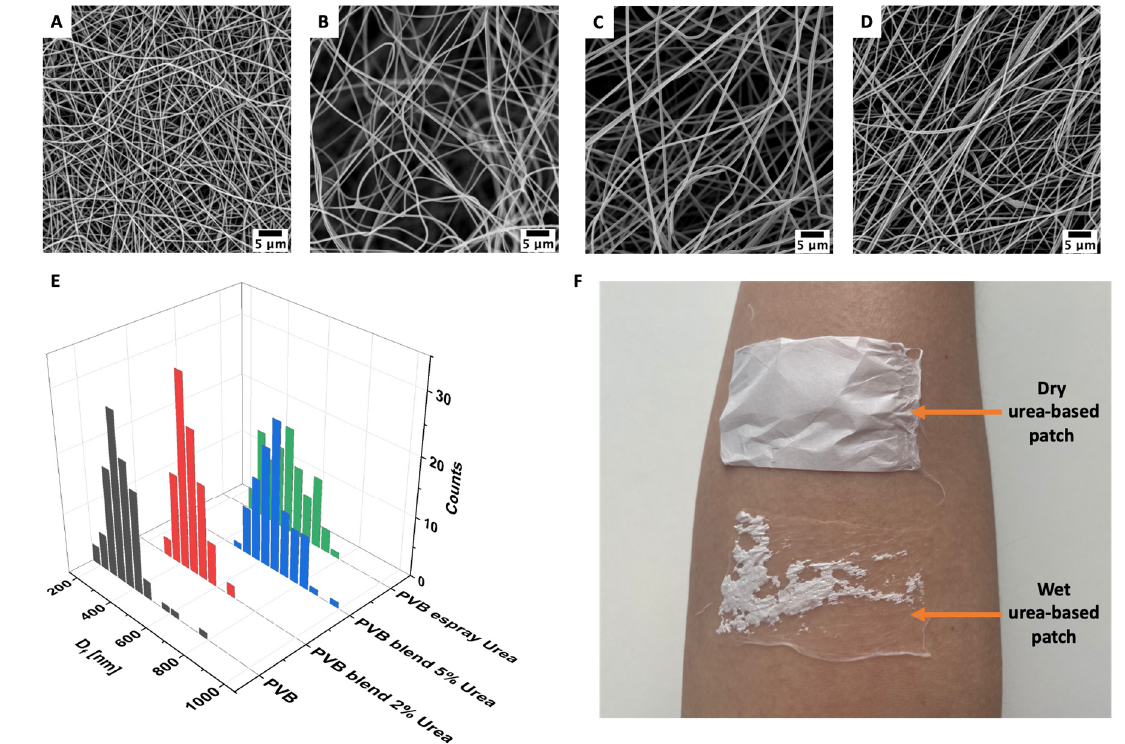
Figure 1. SEM micrographs of electrospun nanofibers, ( A ) PVB, ( B ) PVB blend with 2% of urea, ( C ) PVB blend with 5% of urea, ( D ) PVB fibers electrosprayed with urea solution. ( E ) The fiber diameter distribution showed in histogram. ( F ) Images of patches made of PVB blend with 5% urea, dry and sprayed with water, placed on the skin of the forearm.